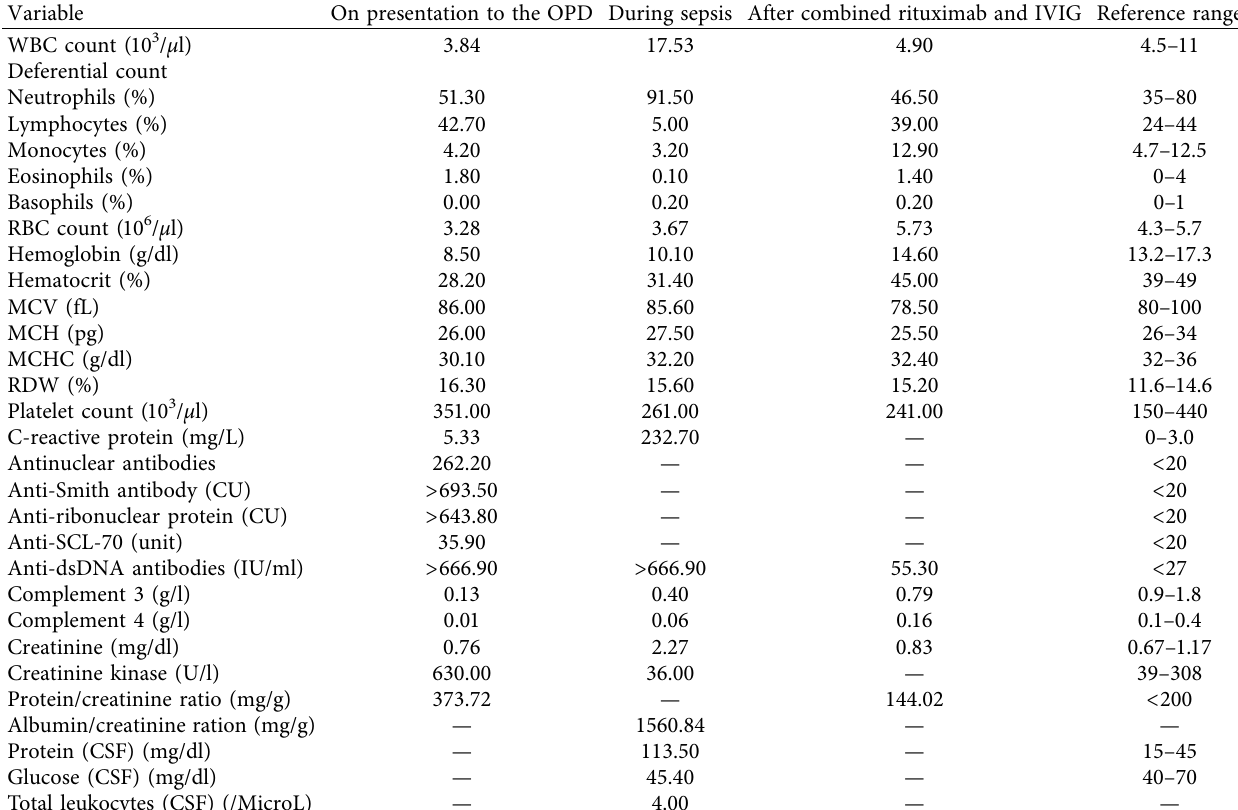
Table 1: Laboratory data through the